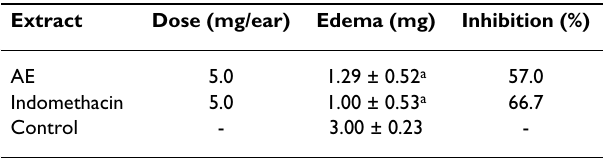
Table 2: Effect of extract on topical acute edema of the mouse ear Extract